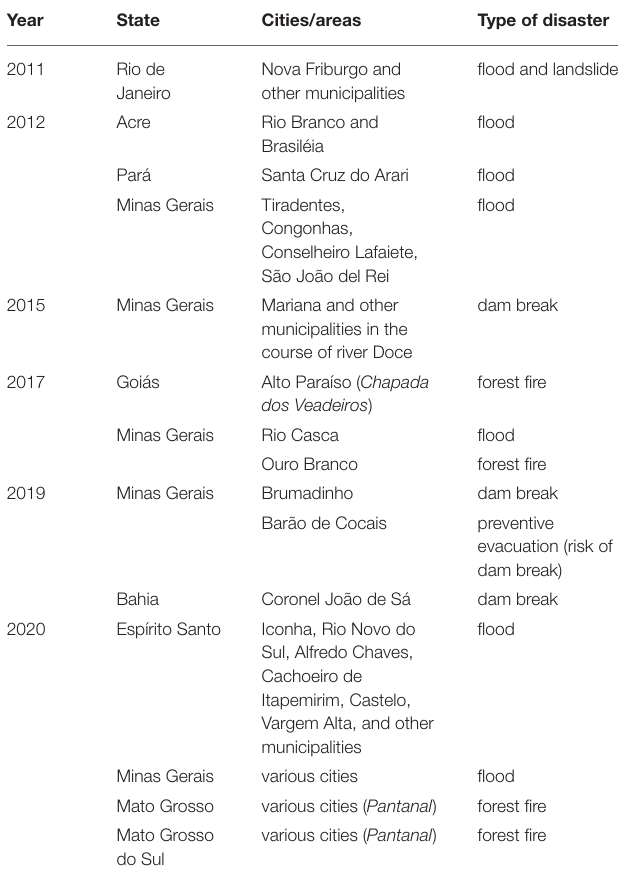
TABLE 1 | Main events with the participation of veterinary rescue teams in the Brazilian states on the last decade,